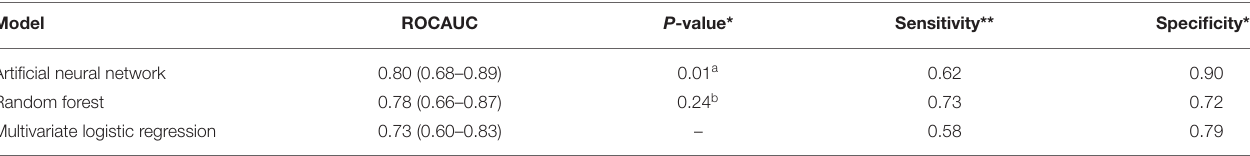
Multivariate logistic regression –